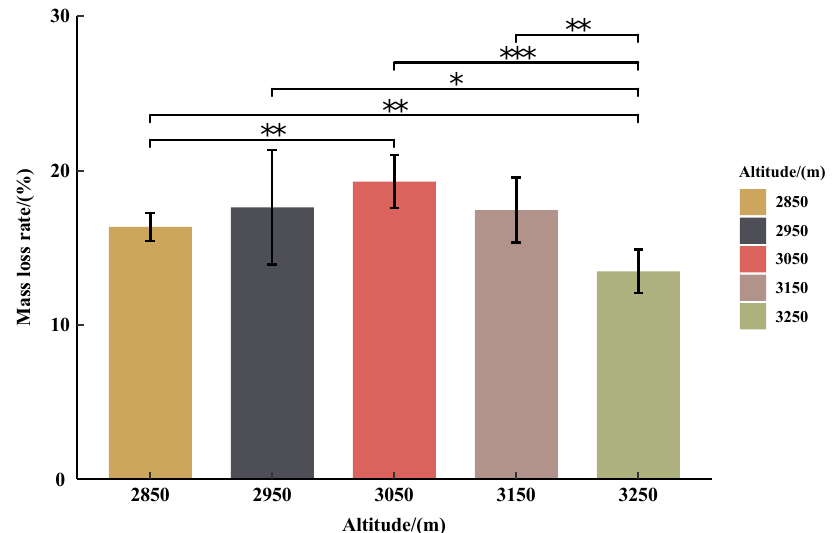
Figure 3. Initial mass loss rate (%) of Qinghai spruce leaf litter at different altitudes in the growing season. Notes: Values are from bulk litter of each site. n = 30. *, p < 0.05; **, p < 0.0l; ***, p < 0.001.